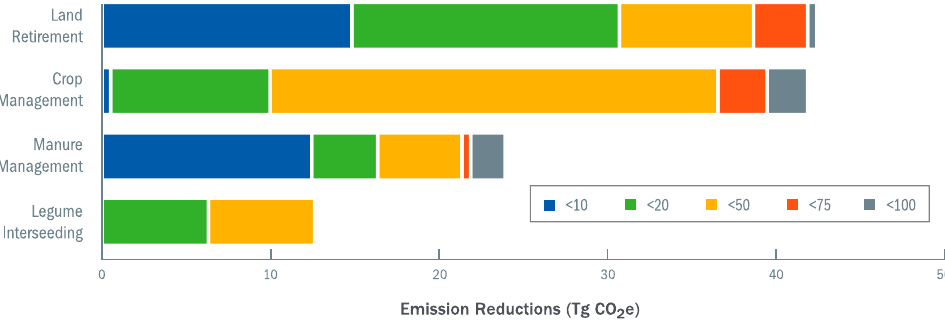
Figure 1. Potential annual mitigation by agricultural practice and price ($/tCO 2 e). Source: [27].